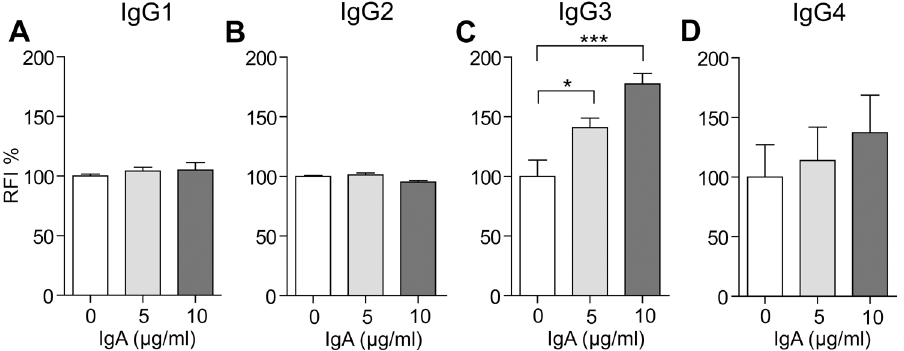
Fig 5. Activation of U937-NF- κ B cells on IgG-coated surfaces in combination with IgA coat. U937-NF- κ B cells were activated on surfaces coated with 5 μ g/ml IgG1 (A), IgG2 (B), IgG3 (C), or IgG4 (D) and with 5 or 10 μ g/ml IgA. The mean fluorescence intensities of the cells exposed to IgGs were normalized to the fluorescence intensities of untreated cells (medium only). For the analysis of combined IgG and IgA effects these normalized values were further divided by the respective IgA treatment values. Results are mean % ± SEM (n = 6) * p < 0.05 versus control (without